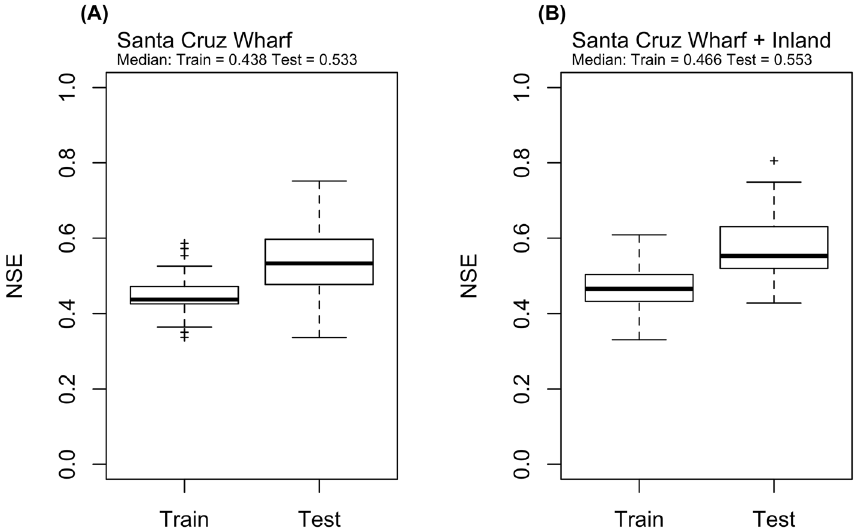
Figure 1. Nash–Sutcliffe Efficiencies (NSE) of the iterative random forest models when tested against training and testing data. ( A ) iRF NSE results for the Santa Cruz Wharf (SCW) only dataset, and ( B ) iRF NSE results for the SCW + inland